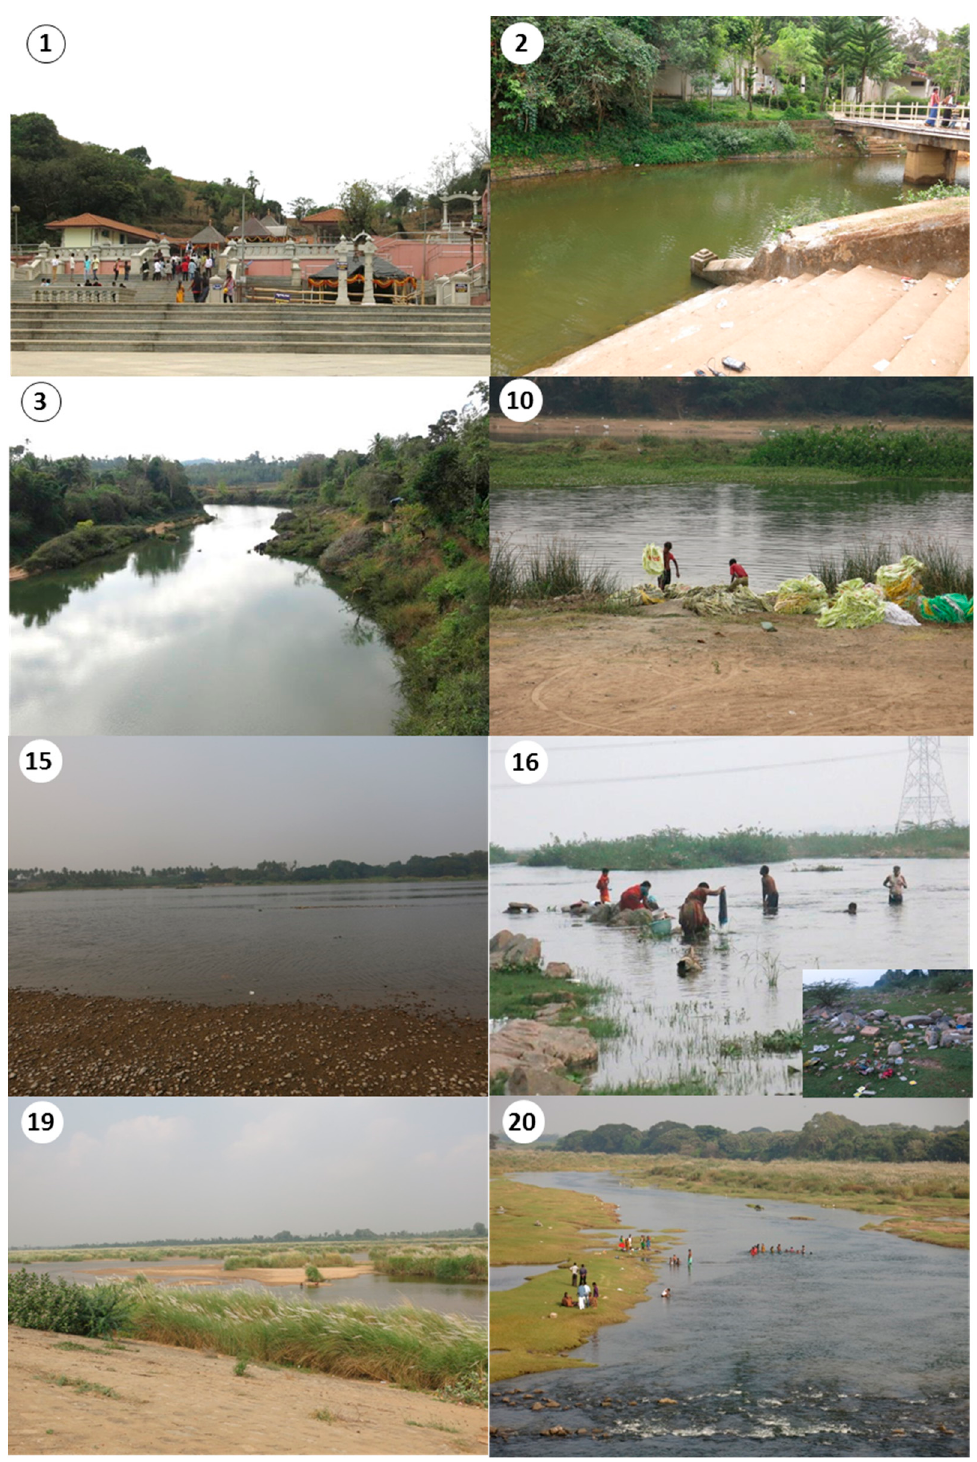
Figure 2. The Cauvery River and its different geomorphology, structure, and human use along the river: The numbers in the pictures present station numbers. Stations 1 (Tala Kaveri, source of the Cauvery River), 2 (Bhagamandala), 3 (Kondangeri), 10 (Shivana-samudra), 15 (Parmathy Velur), 16 (Mohanur), 19 (Trichy), and 20 (Grand Anaicut (Cauvery River discharge)) illustrate differences in regulation, vegetation, sediment character, width, depth, and human impact. Station 1 is a place of highly frequented pilgrimage; at Station 10 , people clean their industry bags; at Station 16 , people wash clothes; Station 20 is used for recreational purposes.